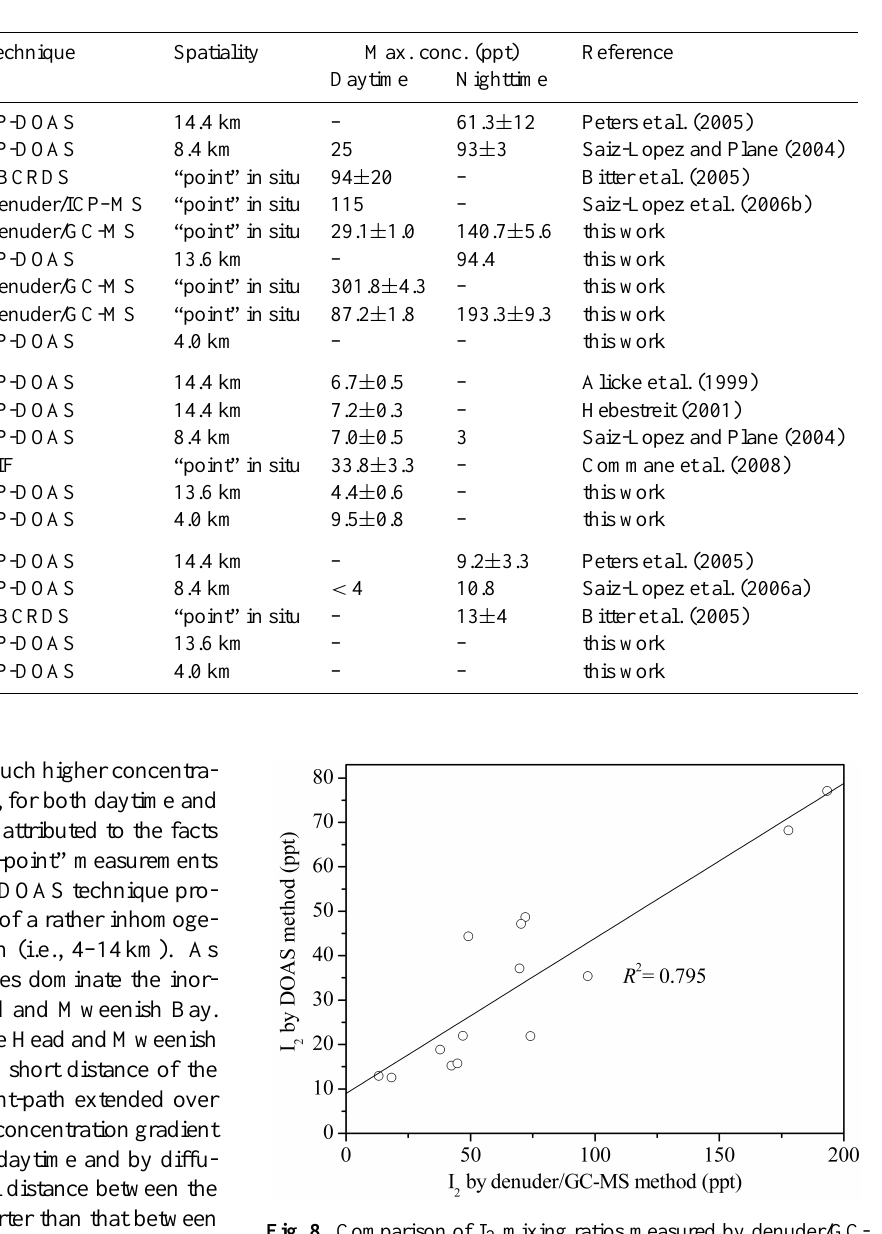
Table 1. Observations of reactive inorganic iodine species (I 2 , IO, and OIO) at Mace Head and Mweenish Bay, Ireland, by different techniques.